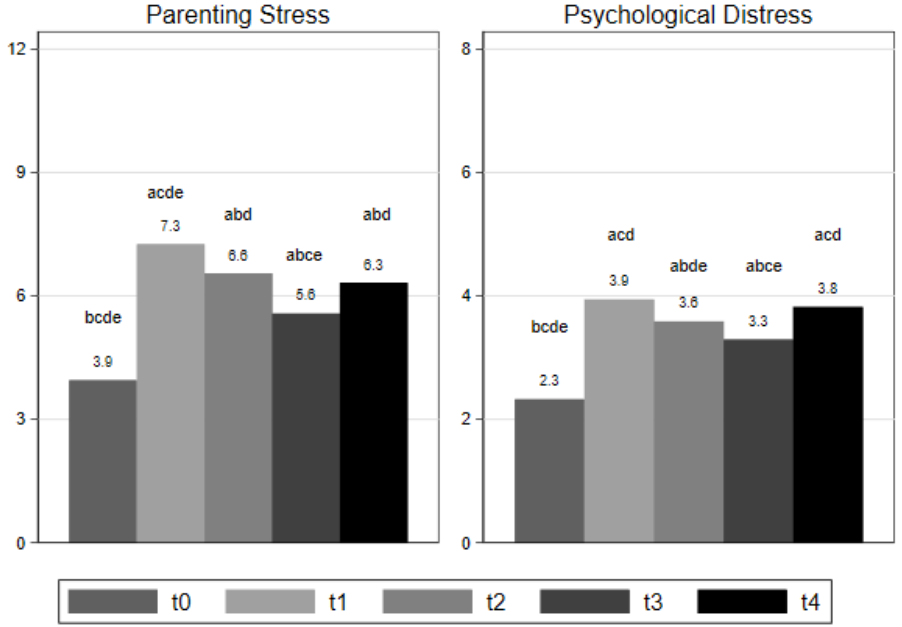
Figure 1 : Sample mean scores for parenting stress and psychological distress before and during the pandemic